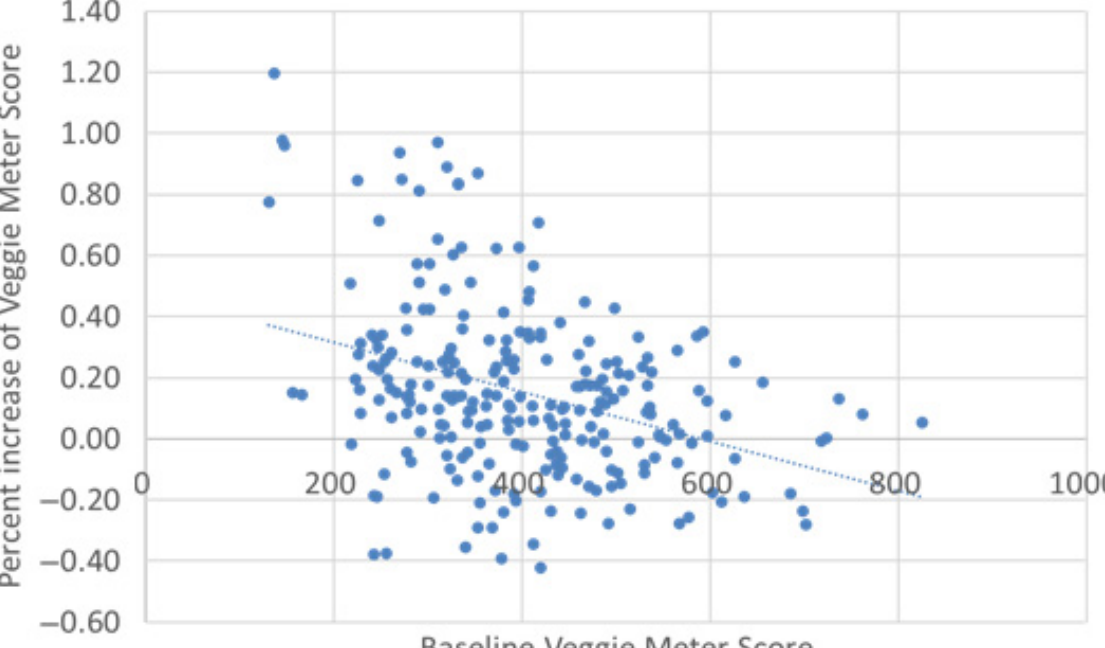
Figure 4. The correlation between baseline Veggie Meter score and percentage of increase in the scores. The percentage of increase had a significantly negative correlation with the baseline values ( r = − 0.36, p < 0.0001).